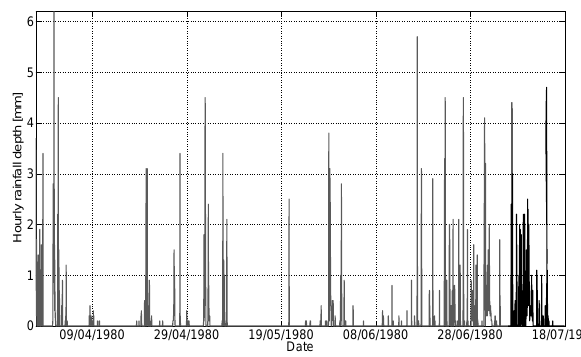
Fig. 9. The rainfall time series used in the rainfall-runoff modelling: the grey storms determine the antecedent soil moisture conditions and the black storm is the historical storm which is replaced by 10000 randomly generated design